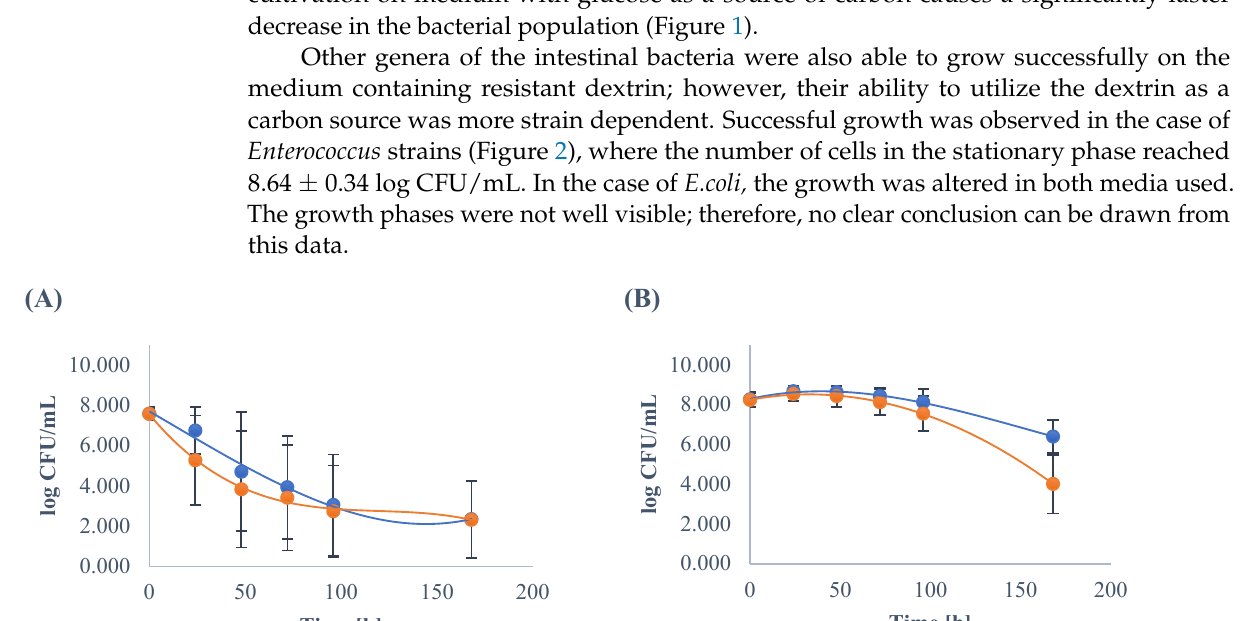
Figure 1. The growth of Lactobacillus ( A ) and Bifidobacterium ( B ) in the medium enriched with the resistant dextrin and with glucose as the control. The results show the means with standard deviations. After 168 h of incubation, the number of both Lactobacillus and Bifidobacterium dropped significantly and was equal to 4.30 ± 1.34 and 4.83 ± 1.41 log CFU/mL, respectively. The minimum and maximum values of the number of Lactobacillus and Bifidobacterium after 168 h of cultivation were also noticeably lower and equal to 2.0 and 2.30 log CFU/mL (minimum); and 7.0 and 8.02 log CFU/mL (maximum). From these results, it may be concluded that cultivation on medium with glucose as a source of carbon causes a significantly faster decrease in the bacterial population (Figure 1). growth phases were not well visible; therefore, no clear conclusion can be drawn from this data.